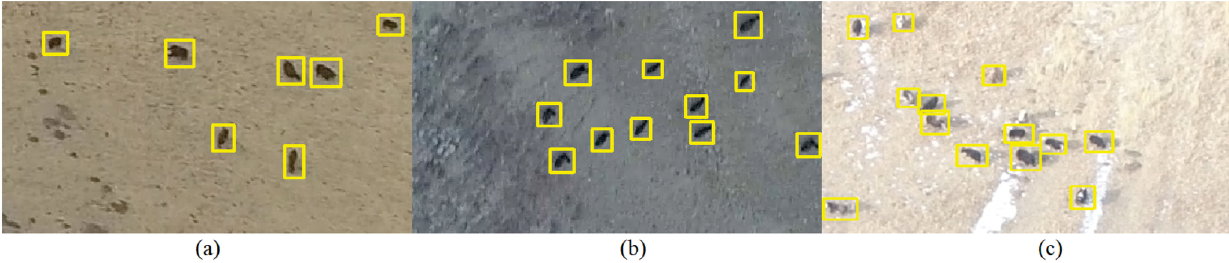
Fig. 1 Examples taken from the livestock dataset. (a)–(c) are cropped examples from Parts I–III of the dataset